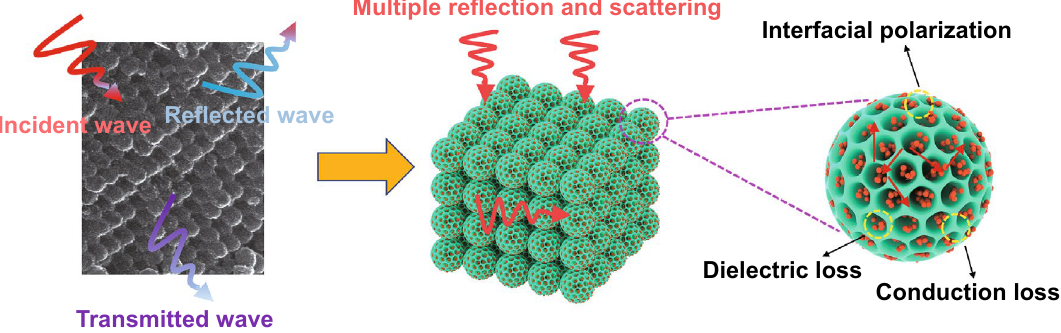
Fig. 10 Schematic illustration of the microwave absorbing mechanism of